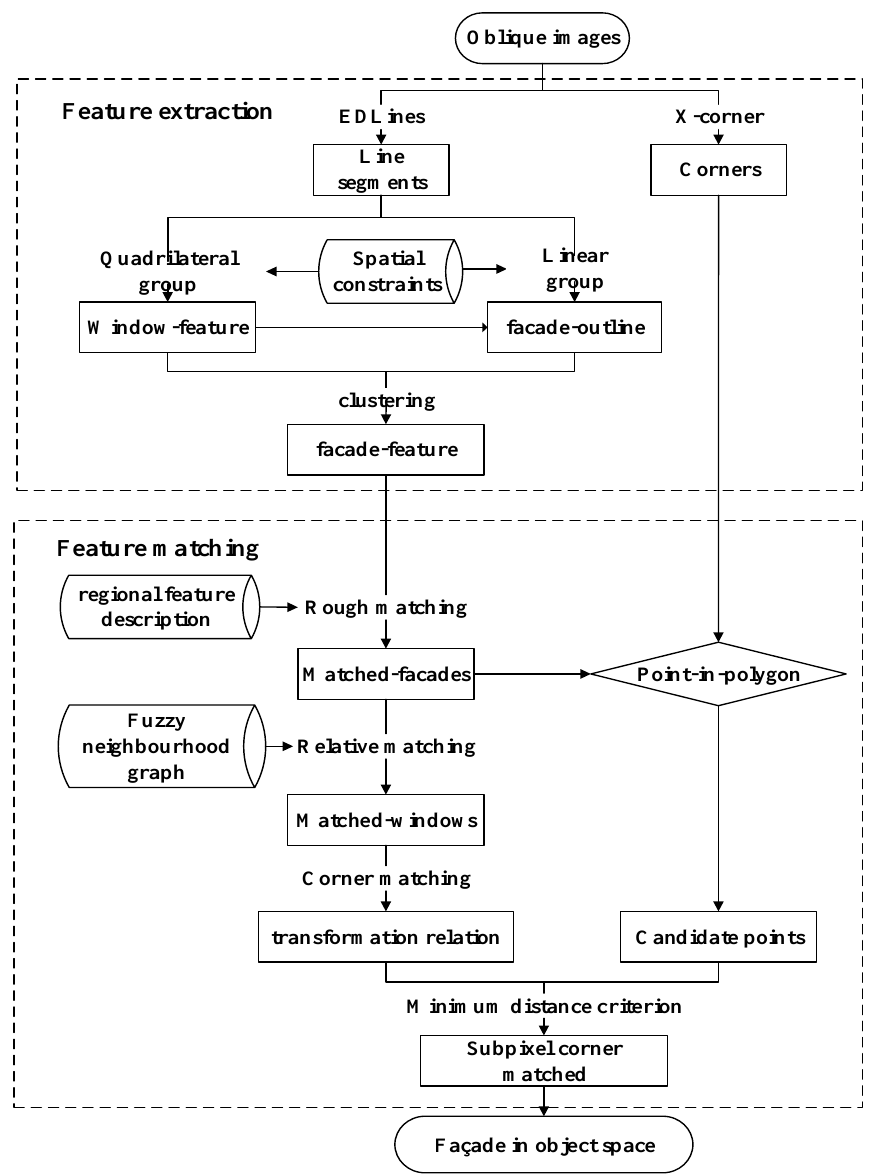
Figure 1. Workflow of façade recognition in the image space and localization in the object space. The feature extraction was performed in three parts. First, straight-line segments were extracted as low-level features from oblique images using a fast and accurate line segment detector. Second, the discrete line segments were grouped as parallelogram window regional features (mid-level features) using spatial constraint analysis with fuzzy production rules and a “take the best” strategy. Third, the high-level features (façade regional features) were created by combining the existing window regional features, including both candidates and fakes, and an outline re-organized by a set of segments because of image noise, occlusions and deficiencies in the line extraction algorithm. Assuming that the façade is rectangular or is composed of several rectangles, the most robust edge of the façade, the border between the rooftop and the façade, was reorganized by a line linking process. The other three vertical corner lines were ignored. Thus, the spatial cluster succeeded in grouping the windows and extended the edge to the integrated outline. X-corners, and especially the angular points of windows, are widely distributed in façade scenes and serve as high-precision correspondences in the final matching process to fit the 3D façade